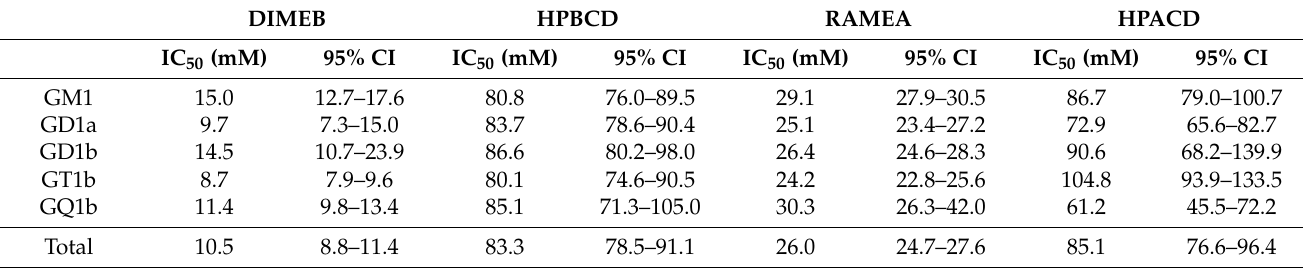
Table 1. The IC 50 values and their 95% confidence intervals (95% CI) of the depletion of individual and total ganglioside content upon DIMEB, HPBCD, RAMEA, and HPACD treatment of the rat cerebral